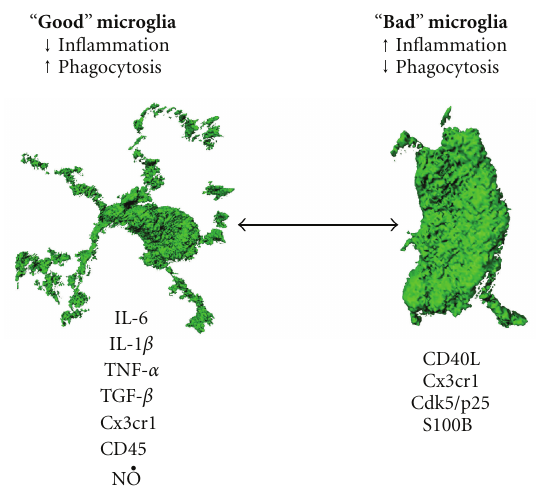
Figure 1: “Good” versus “Bad” microglia in Alzheimer disease. Illustration using 3D models of ramified “good” microglia and ovoid “bad” microglia along with the array of immune molecules